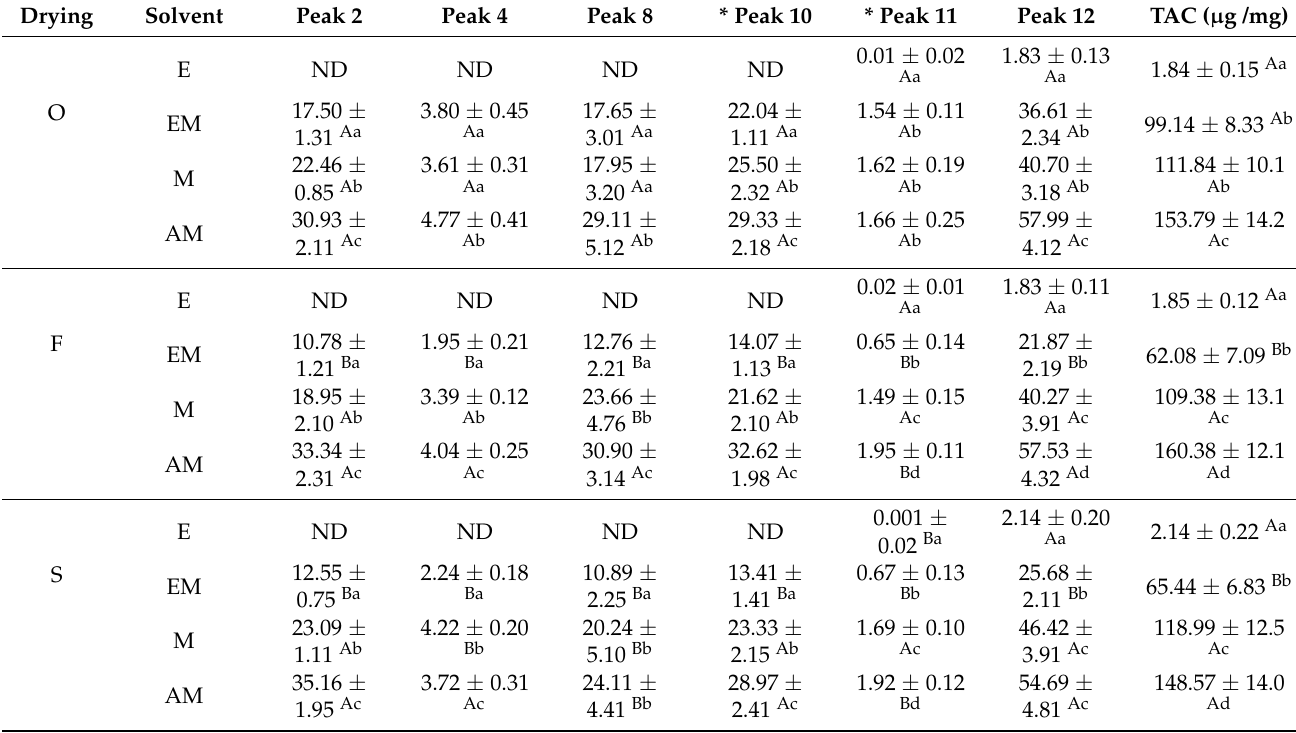
Values marked with different upper-case letters (A,B,C) indicate comparison between drying methods for the same solvent. Values marked with different lower-case letters (a,b,c,d) indicate comparison between solvents for the same drying method. The significant difference is set at p < 0.05. Abbreviations: F, freeze-dried; O, oven-dried; S, shade-dried; H, hexane; E, ethyl acetate; EM, ethyl acetate–methanol; M, absolute methanol; AM, aqueous methanol;TAC, total apigenin content; Peak 2, apigenin-6,8-di- C -hexose; Peak 4, apigenin-6- C -pentose-8- C -hexose (Isomer 1); Peak 8, apigenin-6- C -pentose-8- C -hexose (Isomer 2); Peak 10, vitexin; Peak 11, isovitexin; Peak 12, apigenin-6- C -hexose-8- C - deoxyhexose. ND—not detected. * indicates absolute quantification using respective standard. Not all hexanoic extracts could extract all quantified luteolin and apigenin